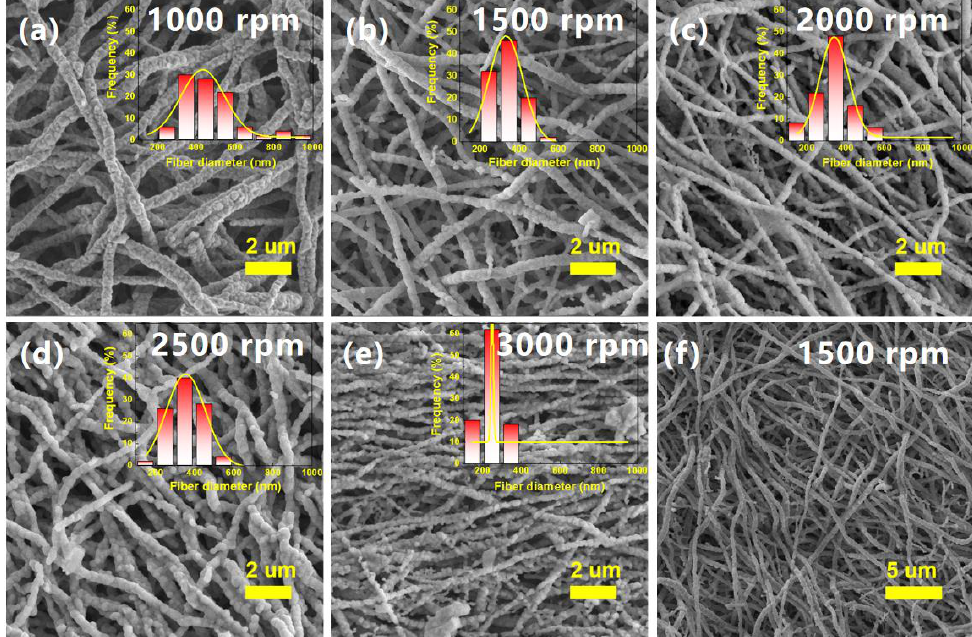
Figure 3. SEM images of NBT nanofibers obtained under different collector rotation speeds at the applied voltage of 20 kV and solution flow rate of 1.0 mL/h: ( a ) 1000 rpm; ( b , f ) 1500 rpm; ( c ) 2000 rpm; ( d ) 2500 rpm; ( e ) 3000 rpm. The inserted figures are the diameter distributions of NBT nanofibers. Table 1. NBT nanofibers diameters under different parameters and the relative contribution of each parameter.